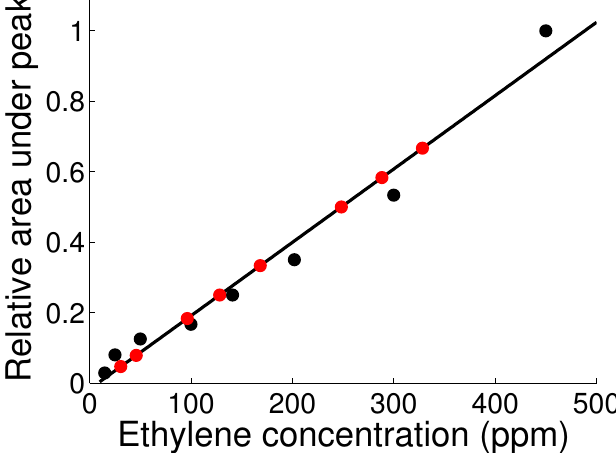
Figure 4. The calibration function (solid line) was adjusted linearly from the calibration points (black markers). Once the calibration function was obtained, it was used to estimate the concentration of ethylene measured in the vicinity of the sensors